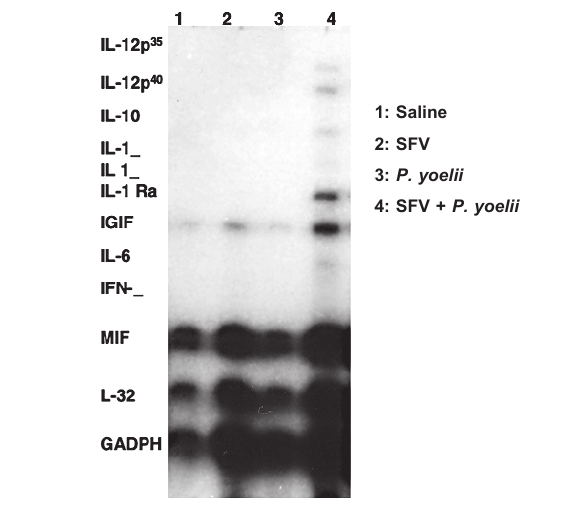
Fig. 3. – Cytokine profile of mouse brain on day 4